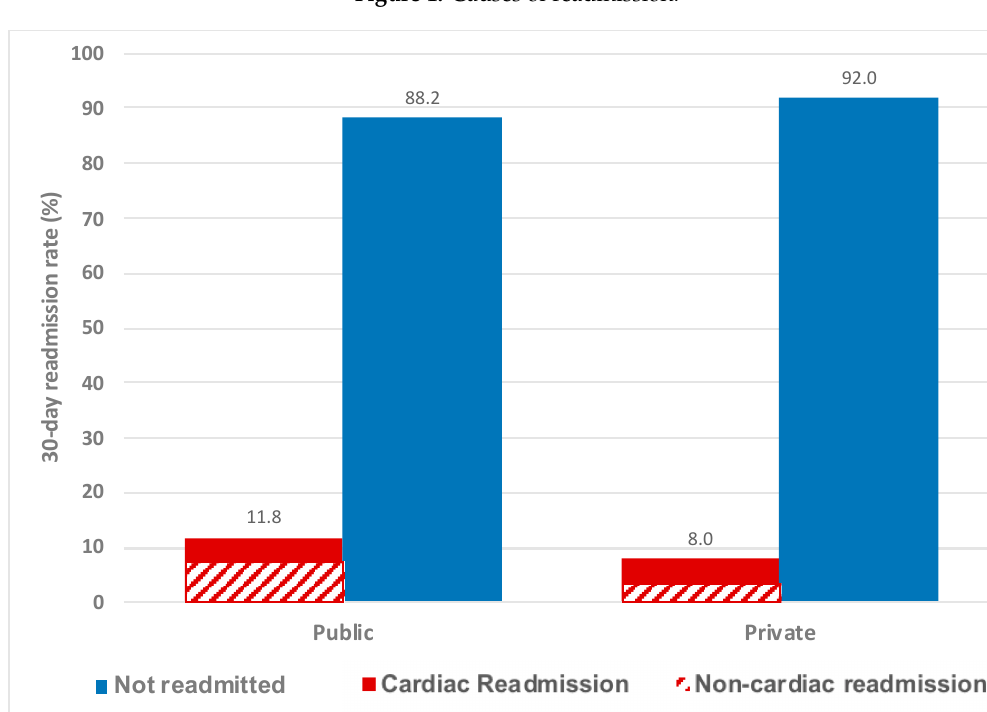
Figure 1. Causes of readmission.